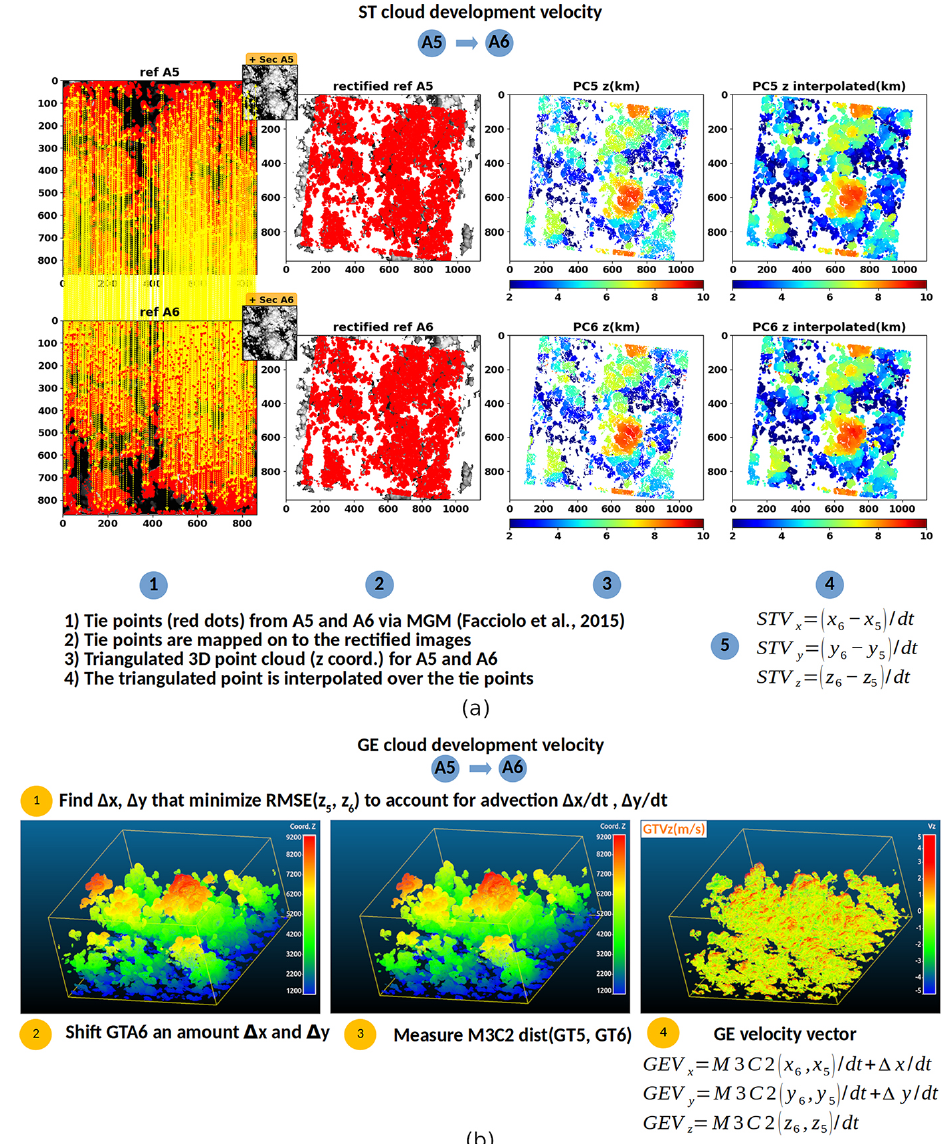
Figure 11. Cloud development velocity algorithms. (a) From ST clouds – (1) tie points from images ST2A5 and ST1A6, (2) tie points are mapped on to the rectified images, (3) 3D retrieved point clouds (for A5 and A6), (4) 3D point clouds interpolated to the tie points, (5) mean ST velocity vector. (b) From GT clouds – (1) (cid:49)x , (cid:49)y that minimise RMSE (z 5 ,z 6 ) are calculated, (2) GTA6 is translated to an amount (cid:49)x , (cid:49)y to account for advection, (3) M3C2 cloud-to-cloud distance is calculated, (4) the mean GE velocity vector is